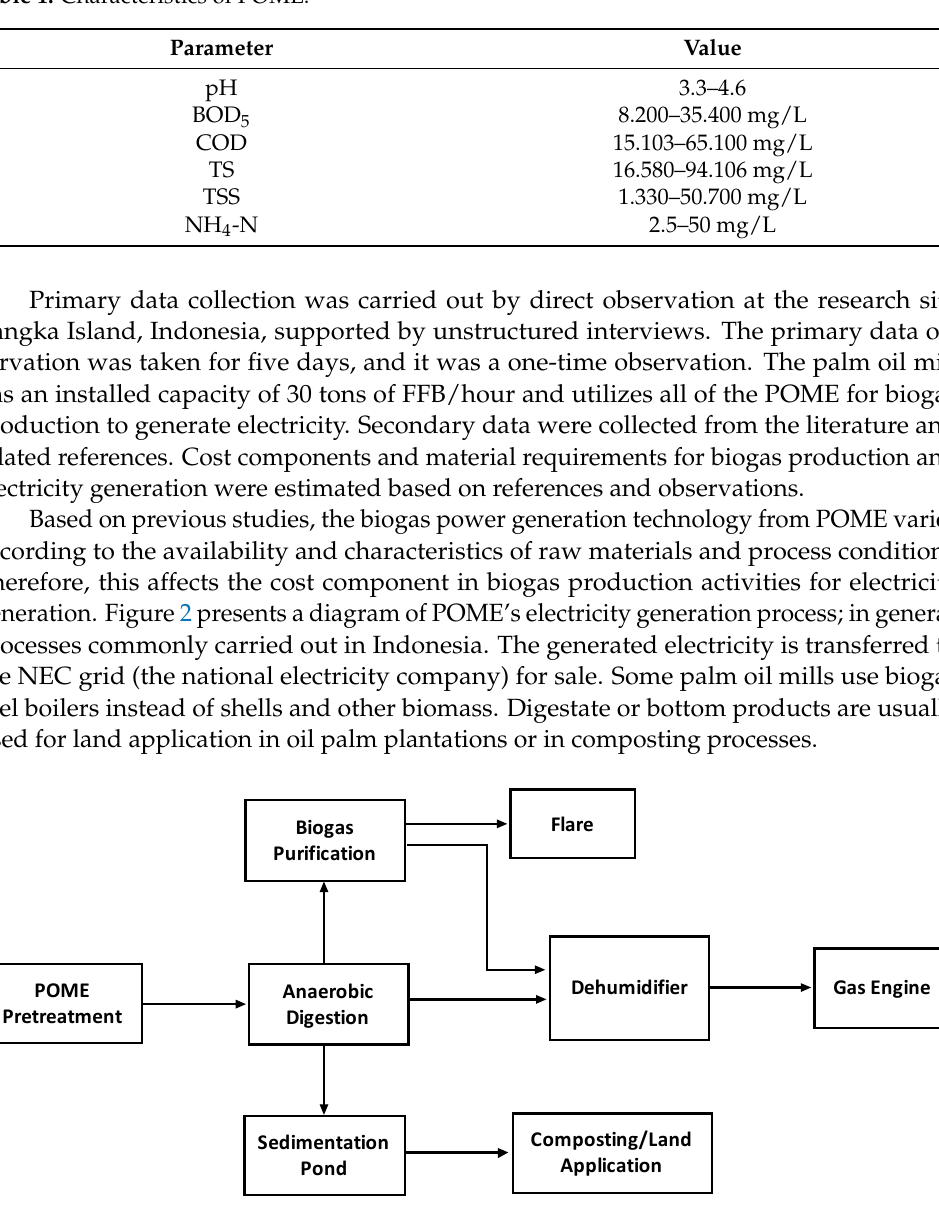
Table 1. Characteristics of POME.